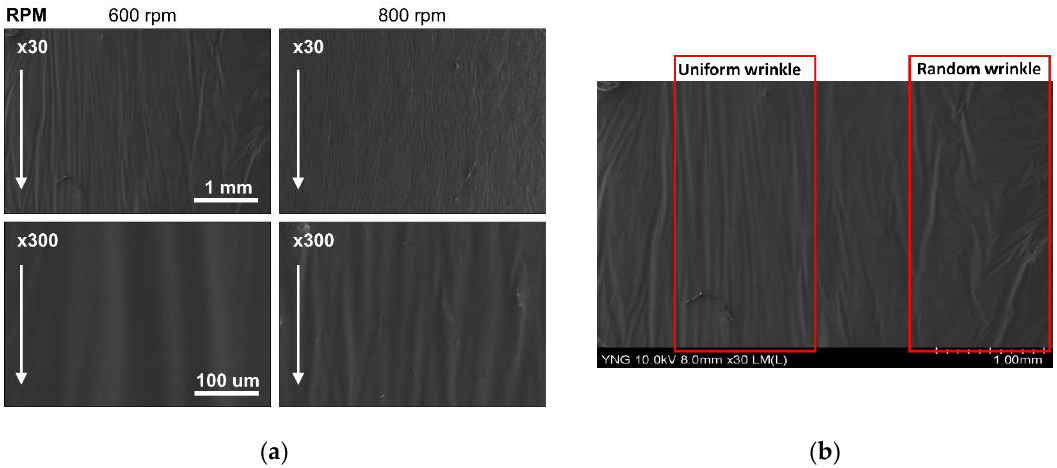
Figure 5. SEM images of magnetic polymer: ( a ) with 600 ( left ) and 800 ( right ) rpm spin coating speed (Magnetic polymer: 30 wt%). Arrows indicate the magnetic field direction by two permanent magnets, ( b ) uniform wrinkle and random wrinkle comparison.